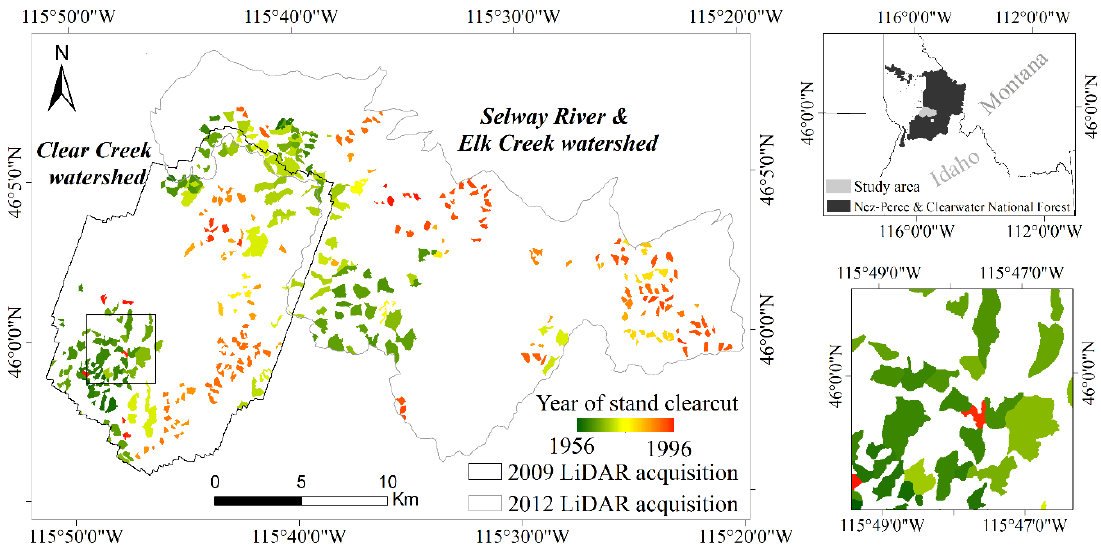
Figure 1. Location of the study area in the Nez-Perce & Clearwater National Forest (Idaho-USA); boundaries of the 2009 and 2012 Light Detection and Ranging (LiDAR) acquisitions; and reference polygons of historical stand clearcuts (>2 ha) from the Forest Service Activity Track System (FACTs) harvest dataset. The FACTs polygons are displayed with a rainbow color scale indicating the year of harvest, from 1956 to 1996. No data are available for clearcuts performed before 1956; no clearcuts (>2 ha) were reported from 1996 to the LiDAR acquisition dates. On the bottom right, a 4 × 4 km subset of the Clear Creek watershed.